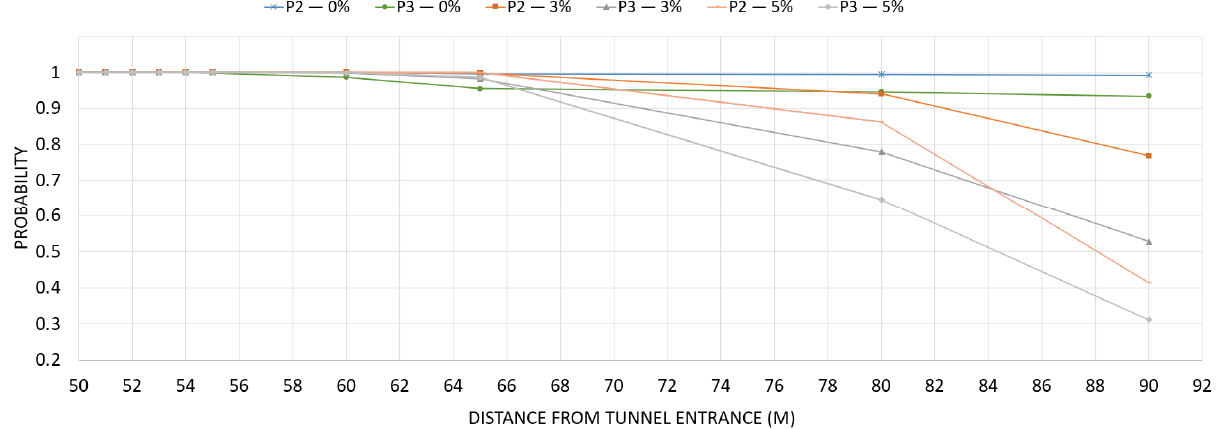
Figure 12. Slope comparison for probabilistic injury at V L = 2.5 m/s, V T = 0 m/s. P2 and P3 refer to the probability of second and third burn injuries, respectively.